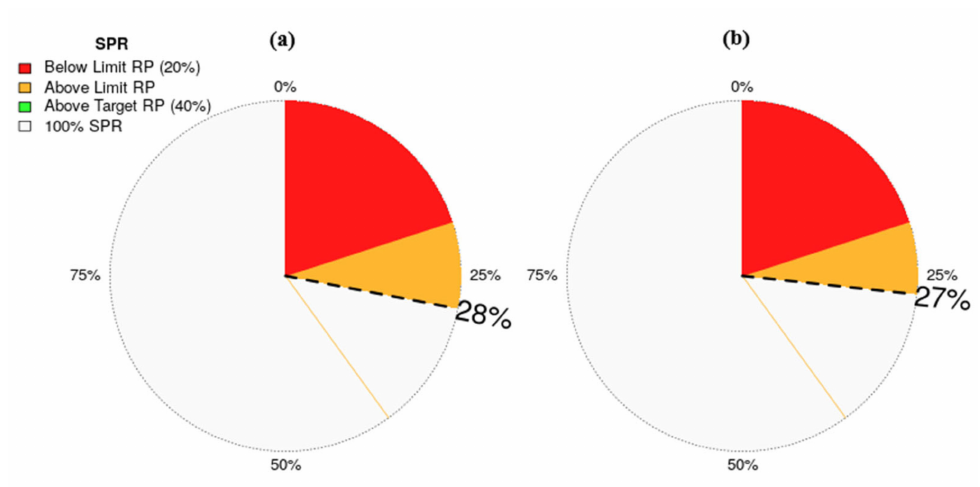
Figure 3. Current spawning potential ratio (SPR) proportions by category of SPR-based reference points for the silky shark in the Pacific Ocean. ( a ) Represents the aggregated year, ( b ) SPR correspond- ing to the last three years period (2018–2020). Table 3. LBSPR annual raw estimates of selectivity (SL50, SL95), fishing pressure (F/M), and spawn- ing potential ratio (SPR) with 95% confidence